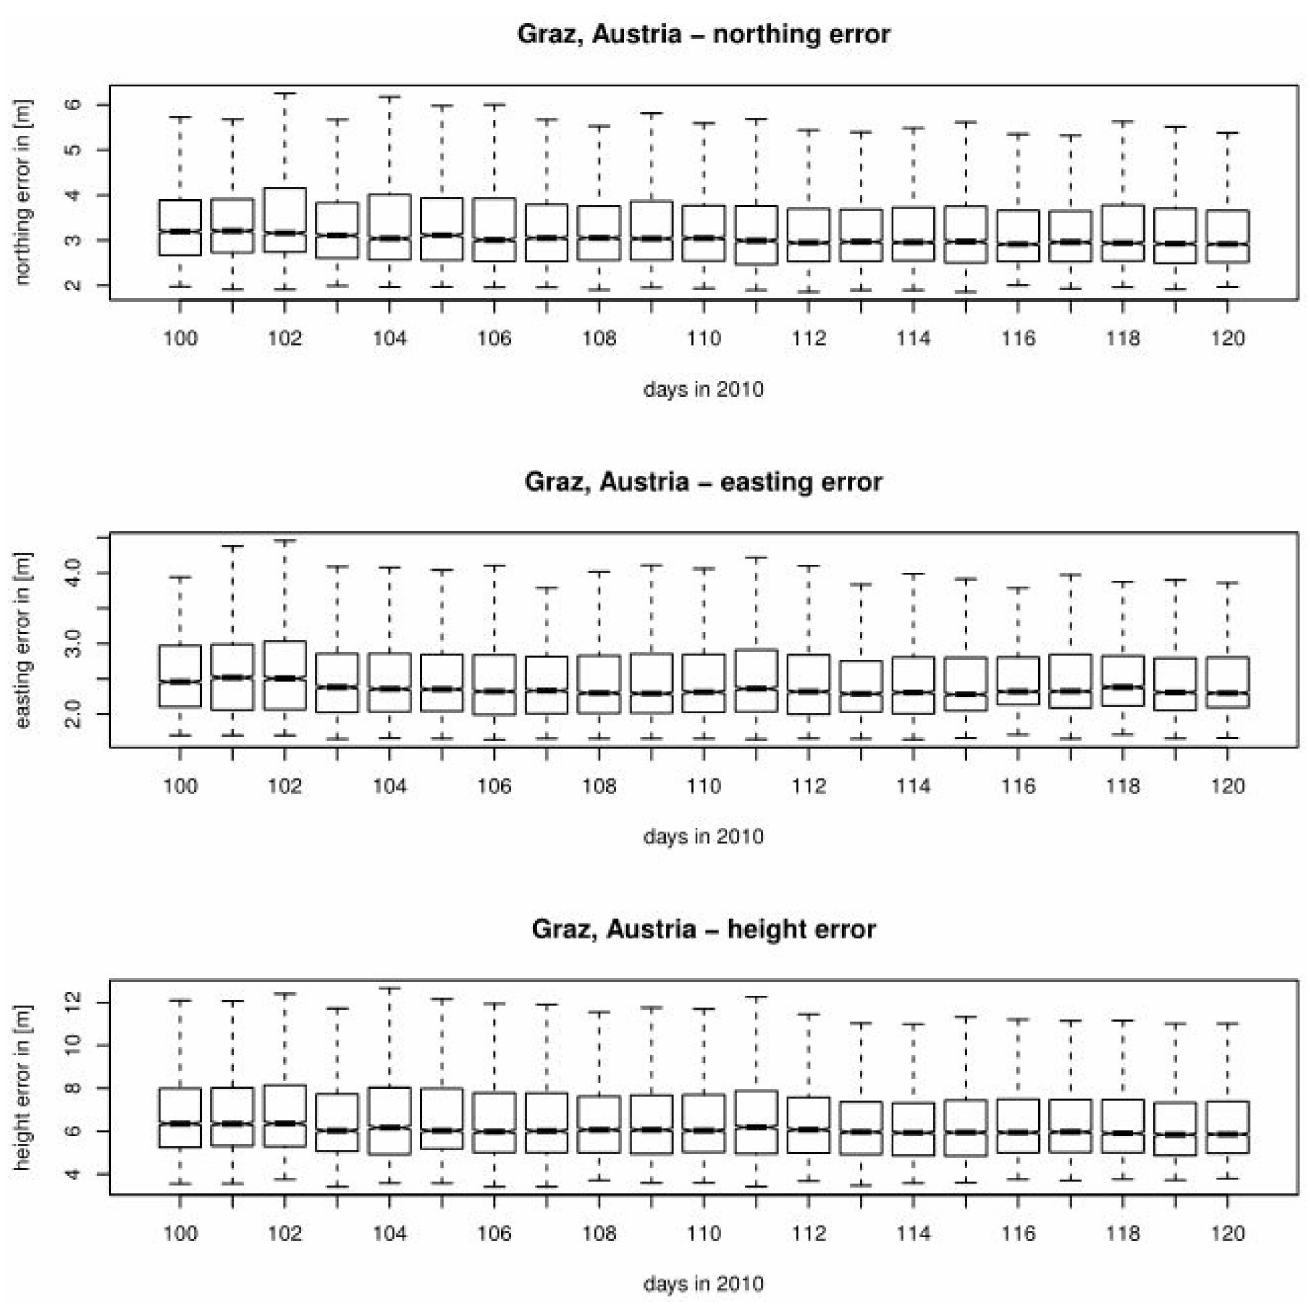
Figure 7. Box-and-whisker plot of GPS positioning errors as observed at Graz, Austria reference station during days 100–120 in